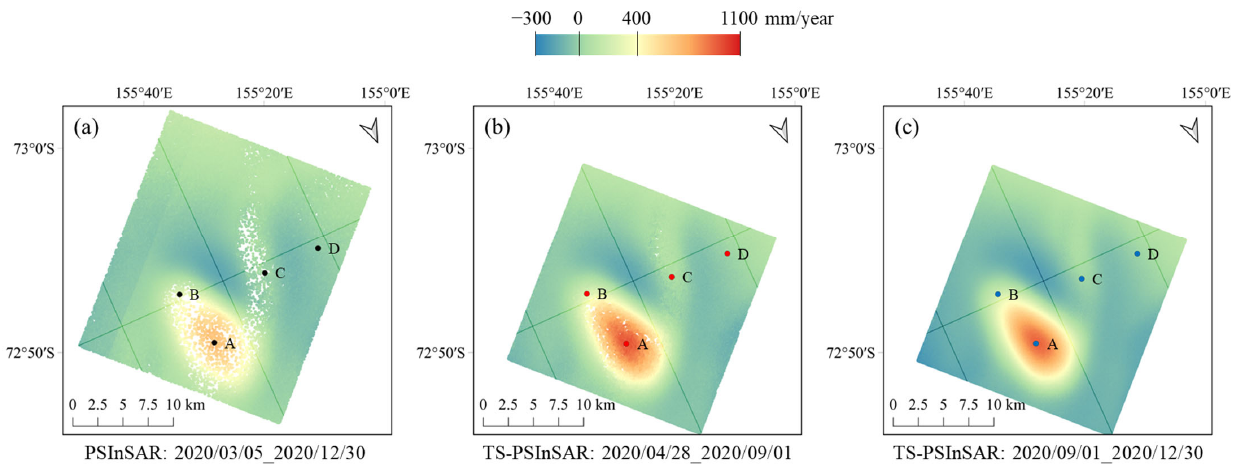
Figure 7. Baseline plots of Sentinel ‐ 1 interferograms performed as a test. The red, blue, and grey lines are the baselines between the master image and the slave images.